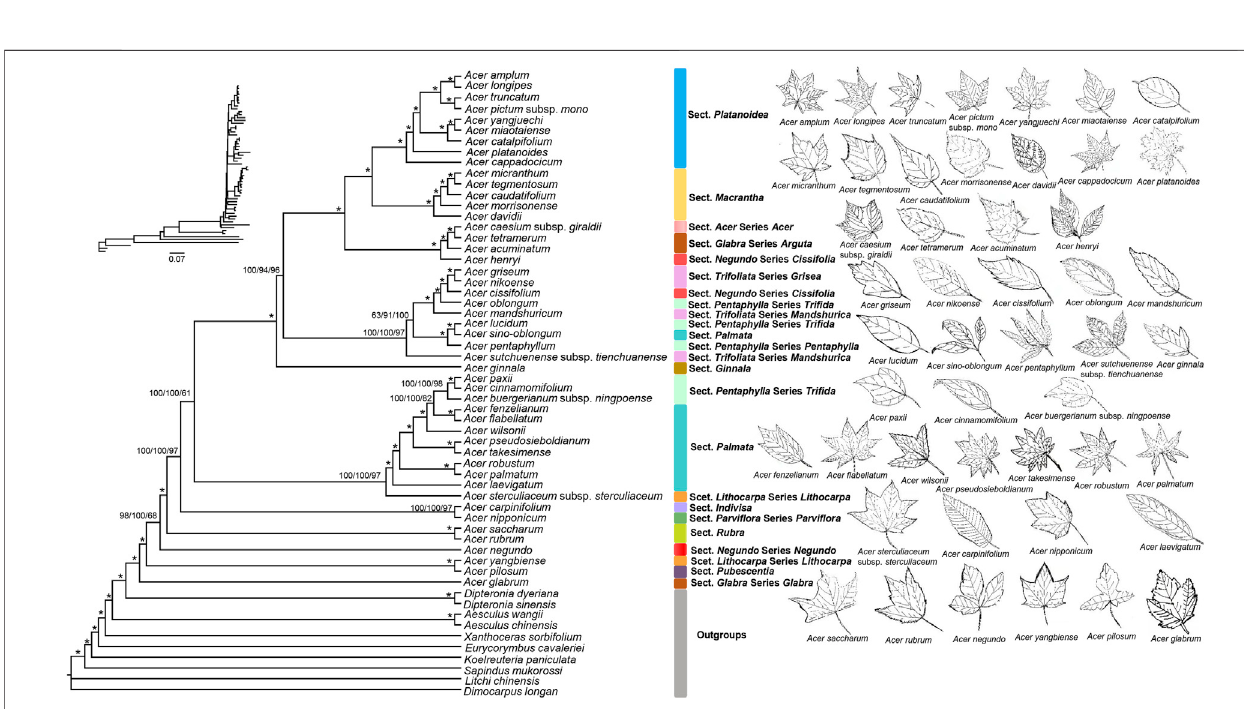
FIGURE4 | Phylogenetictree of48 Acer species inferred by Bayesian Inference (BI), Maximum Likelihood (ML) and Maximum Parsimony(MP) methods, based on the whole cp genome sequences. The numbers above the branches are the posterior probabilities of BI and bootstrap values ofML and MP. Asterisks represent nodes with maximal support values in all methods. Each Section was marked in the same